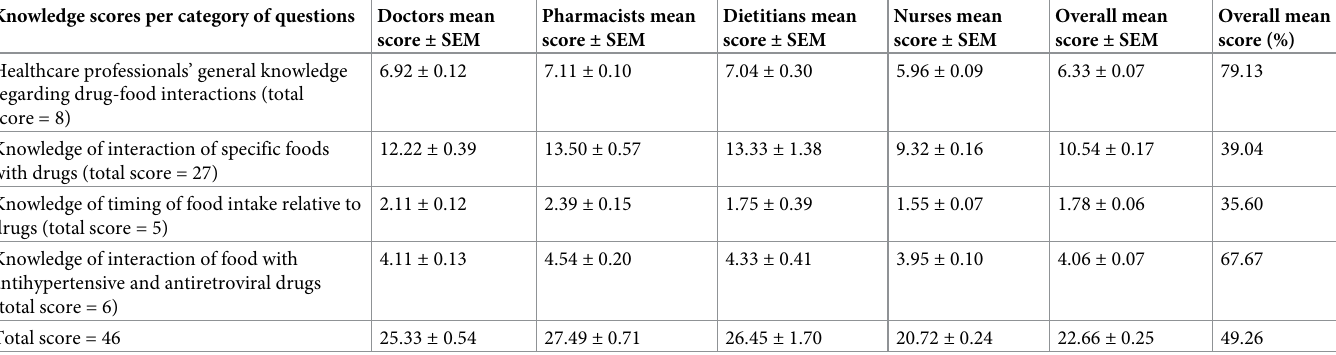
Table 2. Knowledge score of healthcare professionals about drug-food interactions (N =